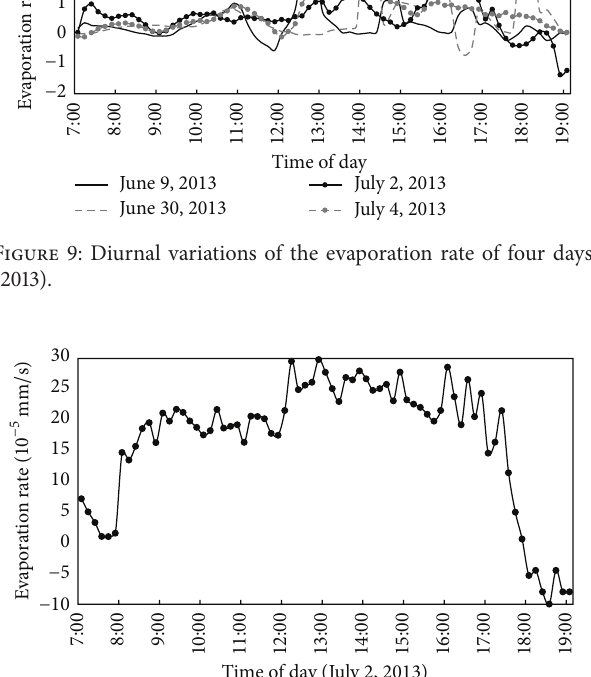
Figure 10: Diurnal variation of the evaporation rate obtained by the aerodynamic method based on the DSAL model (July 2,